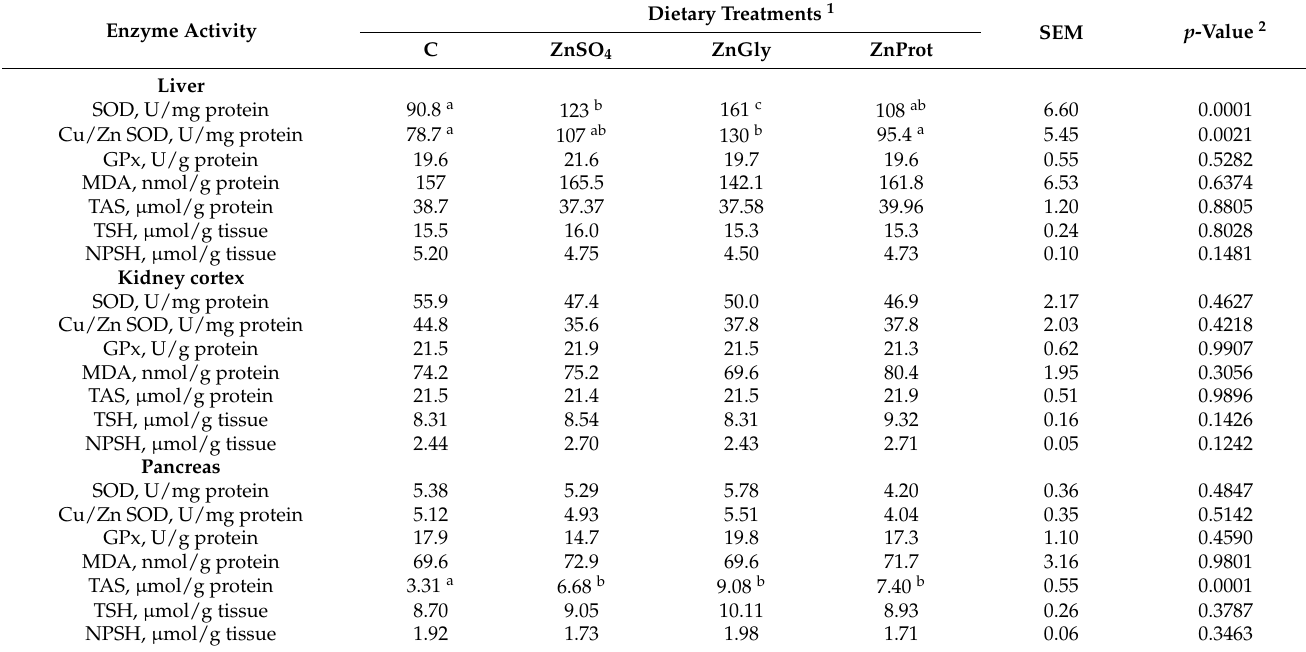
Table 6. Antioxidant parameters in tissues of lambs fed diets (80 mg Zn/kg) differing in Zn source 1 . Enzyme Activity